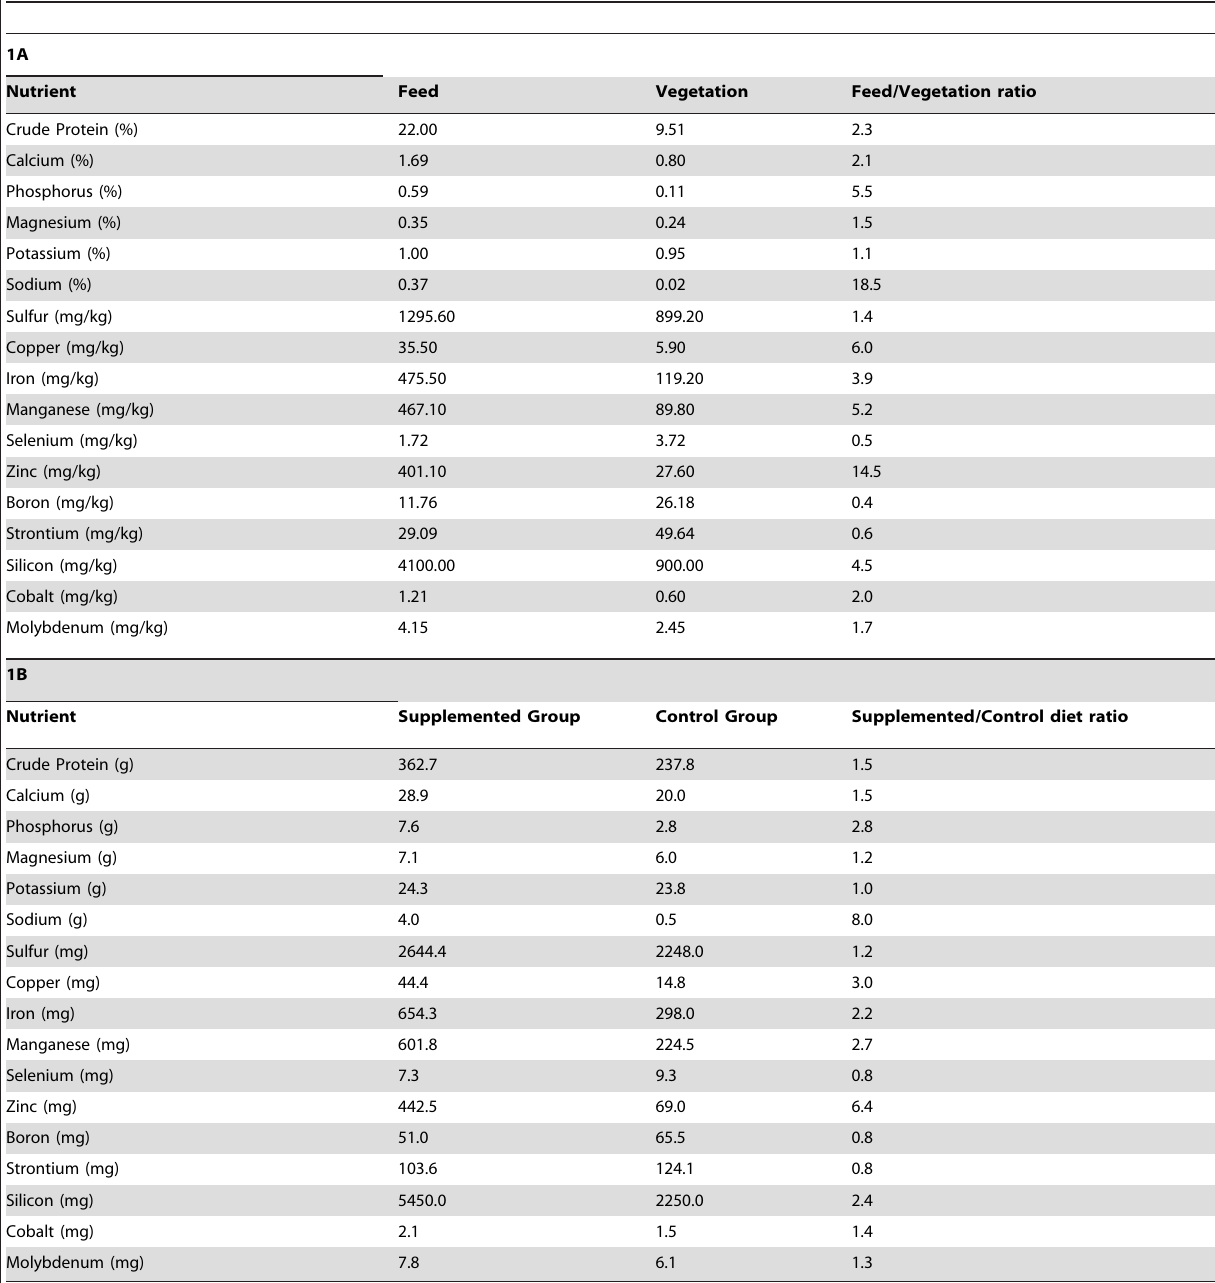
Table 1. Mineral and protein content of supplemental feed offered to Iberian red deer hinds at 1 kg individual 2 1 day 2 1 , and mean mineral content in main chewed plant species present in the study